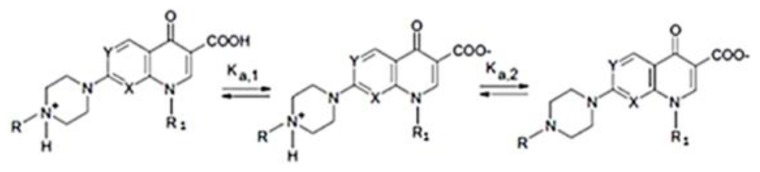
Acid-base equilibrium for piperazinyl quinolones, for HPPA X = Y = N, R = H and R2 = CH2CH3.